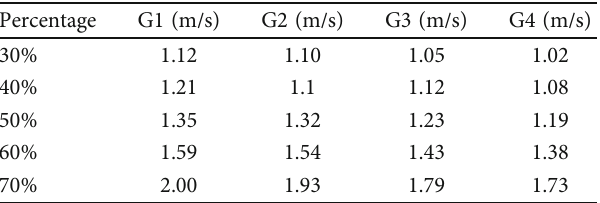
Figure 3: Velocity pro fi les ) m/s ( for the model of 70% stenosis in 10 points starting 1D before the base of the stenosis to 6D after the stenosis: (a) Group 1 .(b) Group 2 .(c) Group 3 .(d) Group 4. Table 2: Maximum velocity at the stenosis throat at the peak fl ow rate.